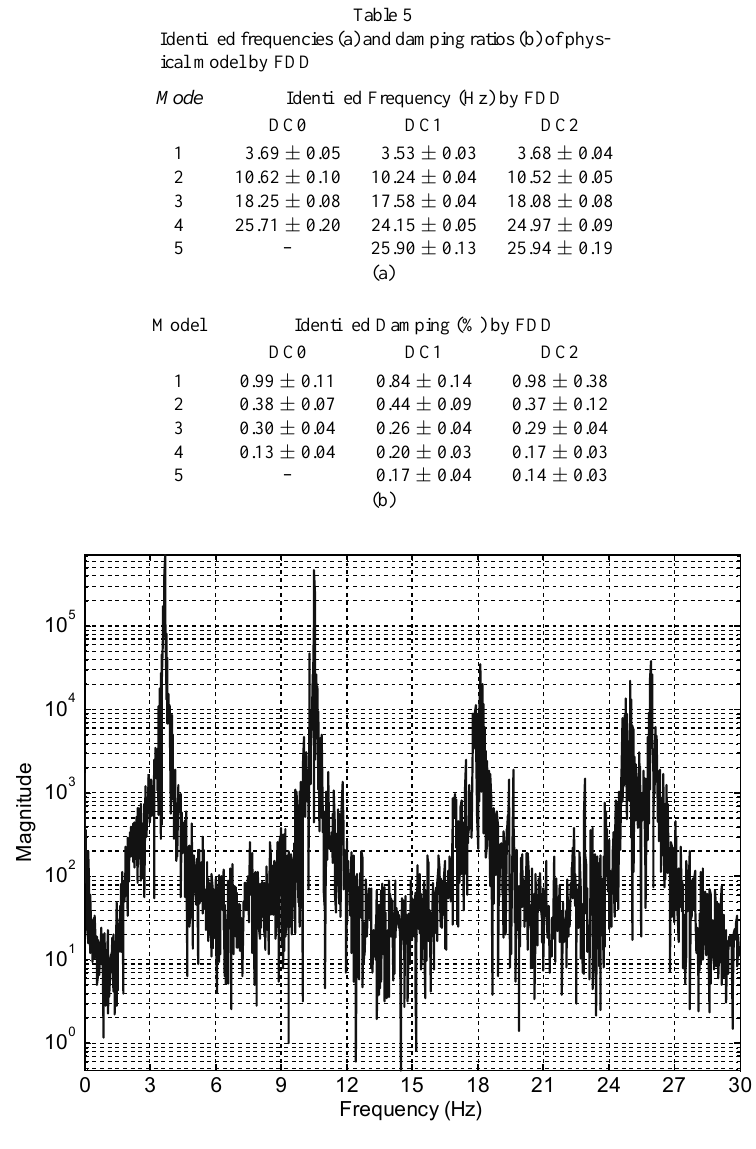
Fig. 11. Dominant singular value for output PSD, DC2